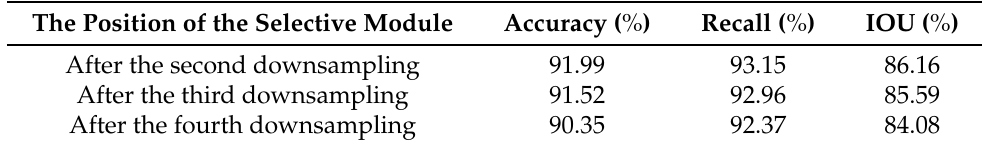
Table 2. Ablation experiment results of the selective module.